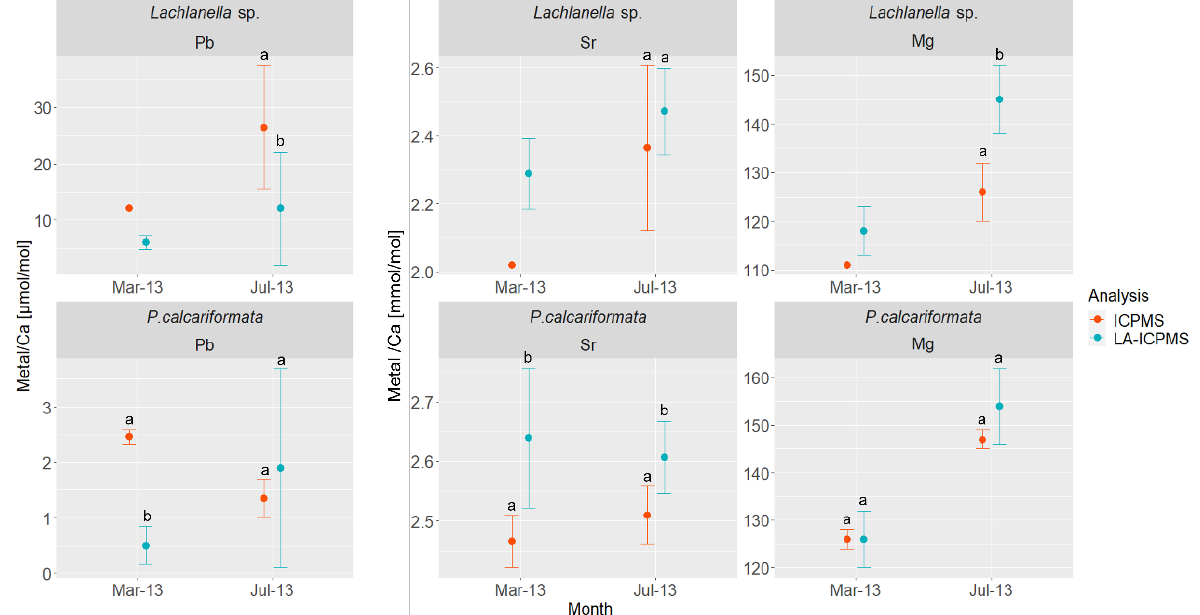
Figure 3. Comparison between specimens collected during March 2013 and July 2013 measured by both ICPMS and LA-ICPMS. The blank-to-signal ratios of Cu and Zn ICPMS analyses were too high and therefore could not be used in this comparison. Letters show statistically significant differences between the analytical